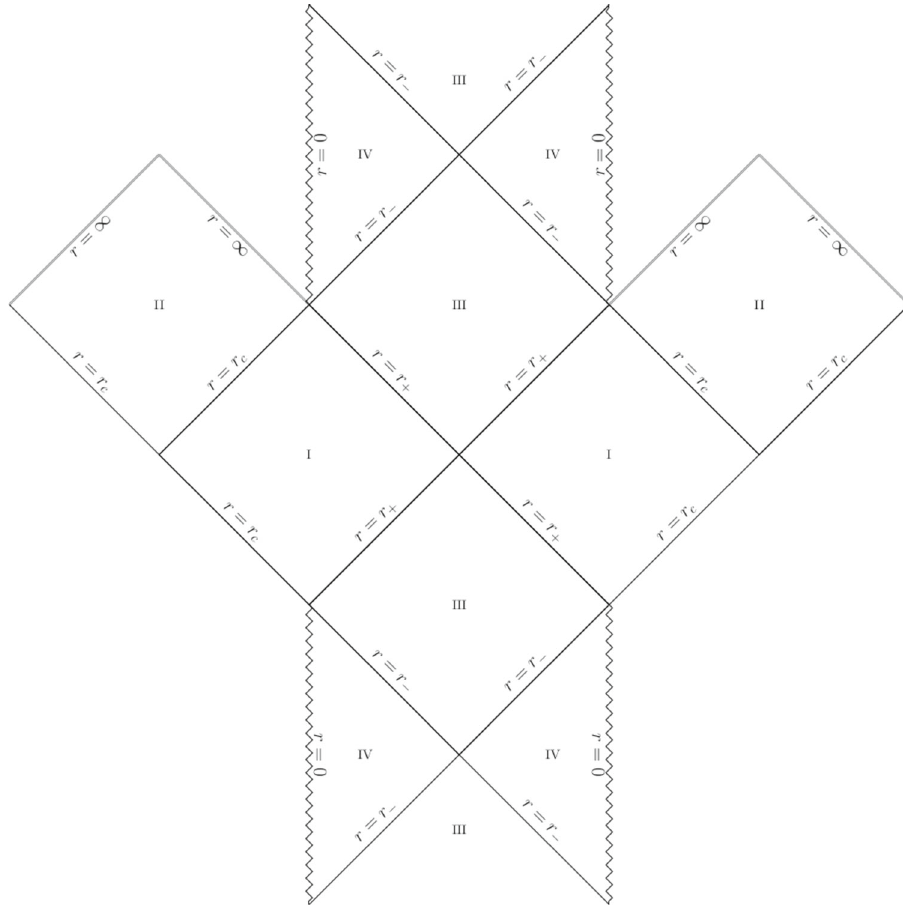
Fig. 1 Penrose–Carter diagram for the four-dimensional black hole with w f = − 1 / 2 and w = − 2 / f